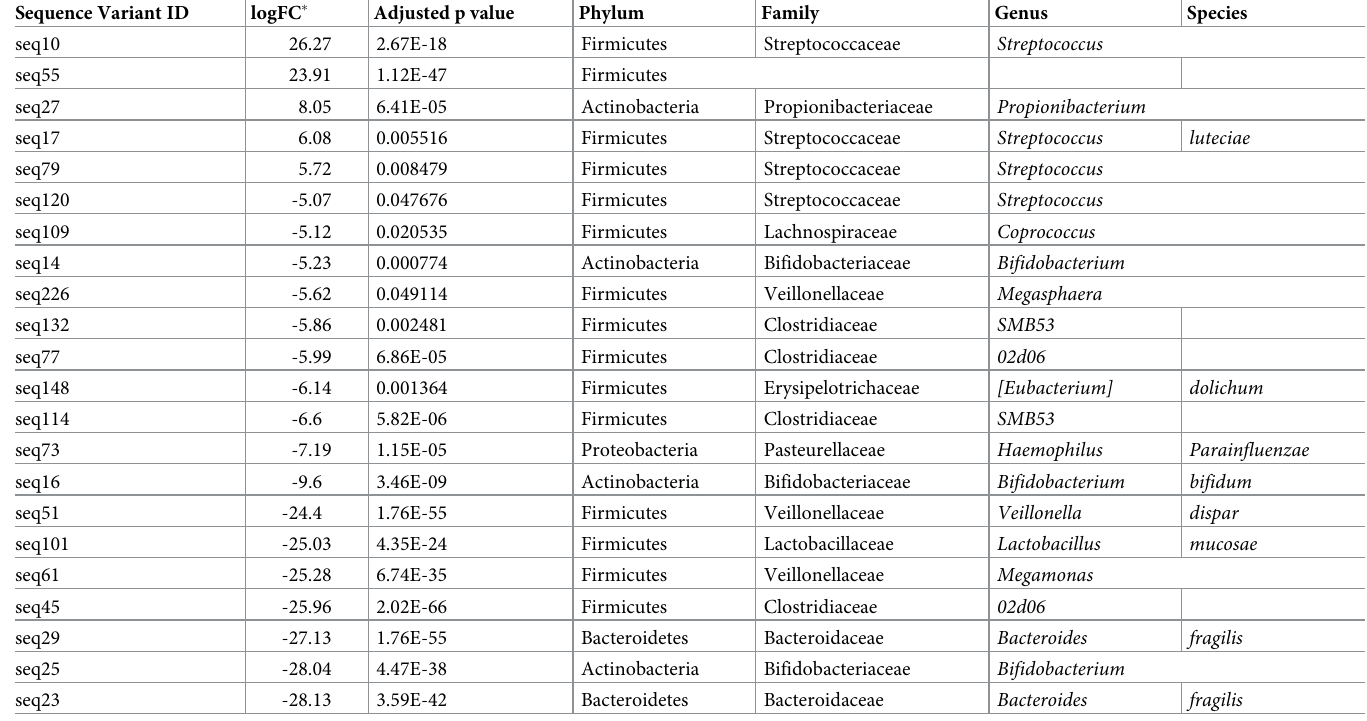
Table 3. Sequence variants with significant differential abundance between samples collected before and after weaning.